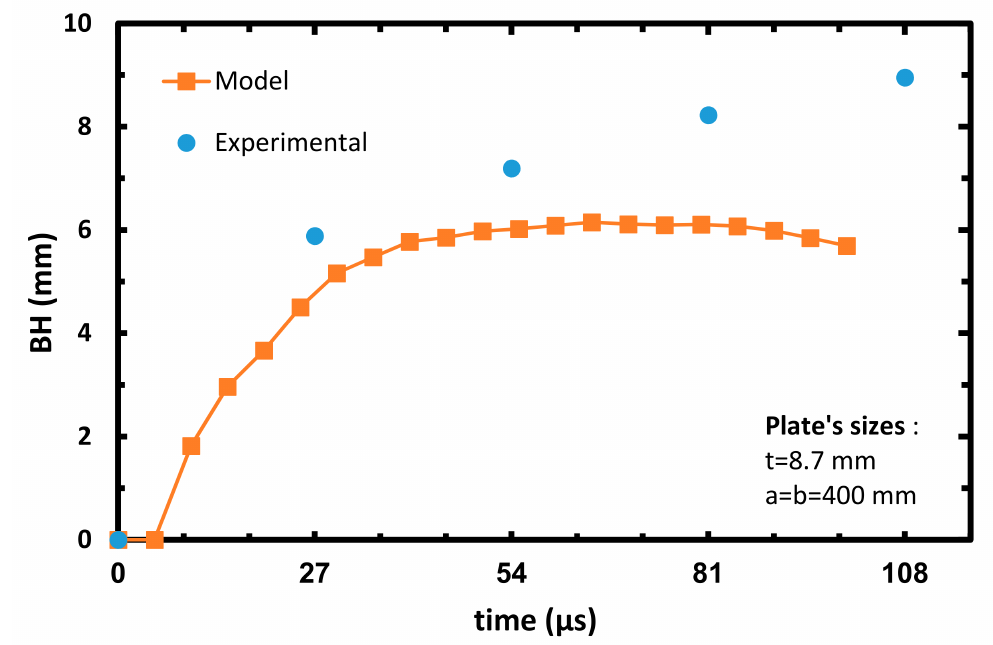
Figure 13. Plate’s bulge height vs. time of the calibrated model, Vinitial = 413